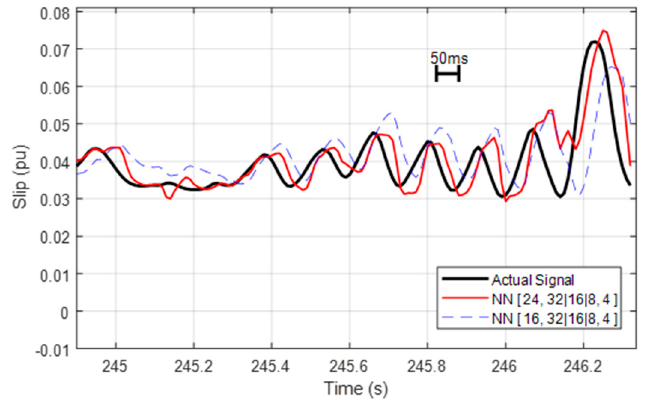
Figure 13. Worst case plot of a 50 ms horizon slip prediction on the front-left wheel with two NN topologies (extract of the most adverse situation among over 10min of driving).